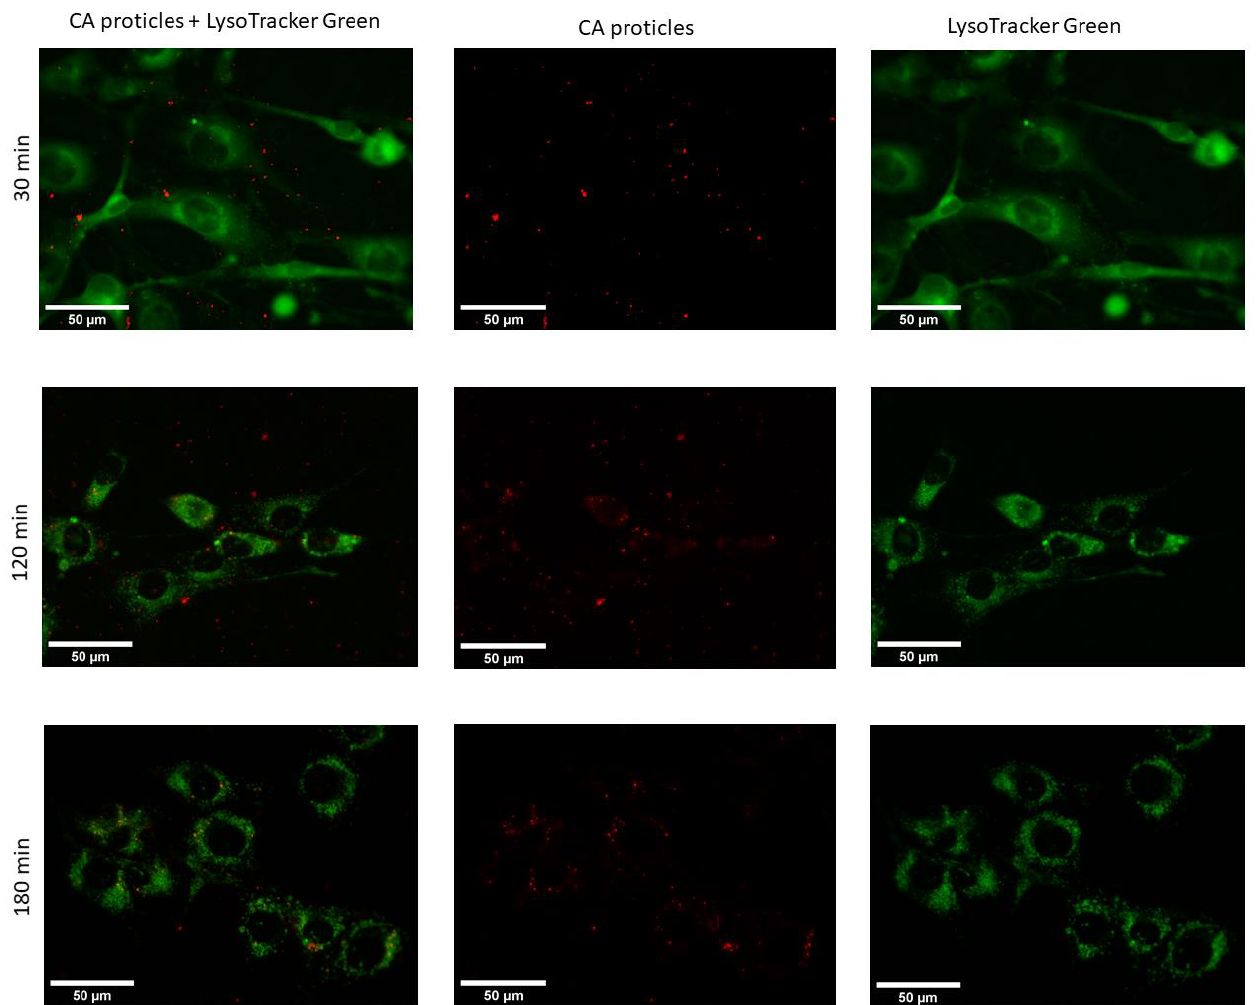
Figure 11. Fluorescence microscopic images of living 3T3-L1 cells at 37 °C transfected with CA- proticles (protamine:CA molar ratio of 1:10) (red) at 400 nM (30 min, 120 min, and 180 min post- transfection). LysoTracker ® Green was used to stain the lysosomes inside the cells.